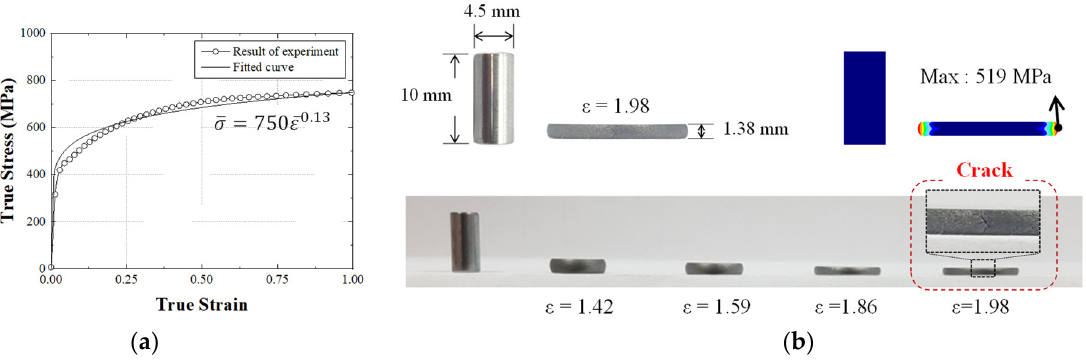
Figure 4. ( a ) Fitted flow stress–strain curve obtained from the compression test, ( b ) upsetting test results for various height reductions.